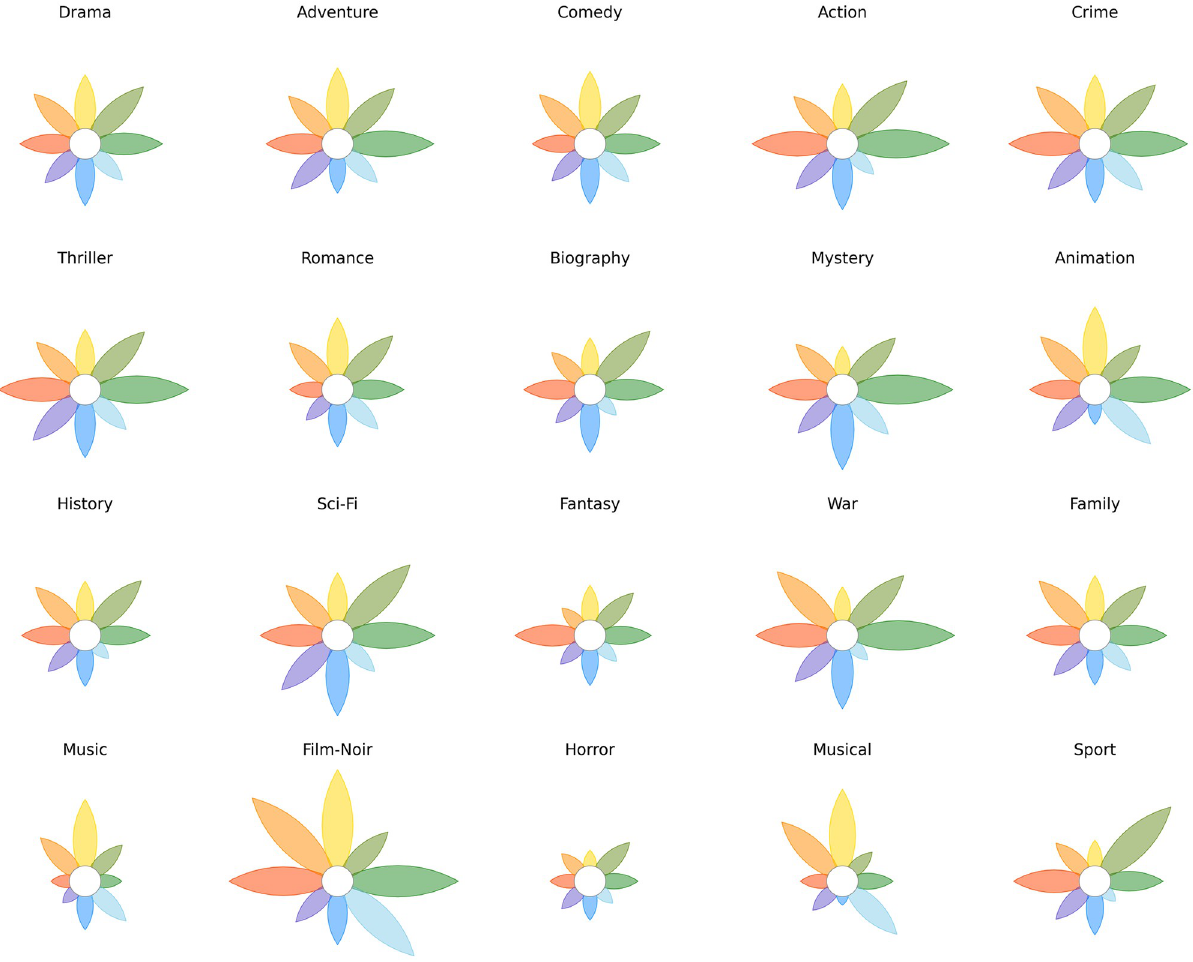
Fig 13. Emotions in the synopses of the 20 most common movie genres in the IMDB database. Coordinates, grids and labels are not visible: this is an overall view of the corpus, meant to showcase general trends and to spot outliers that can be analysed at a later stage, in dedicated plot.